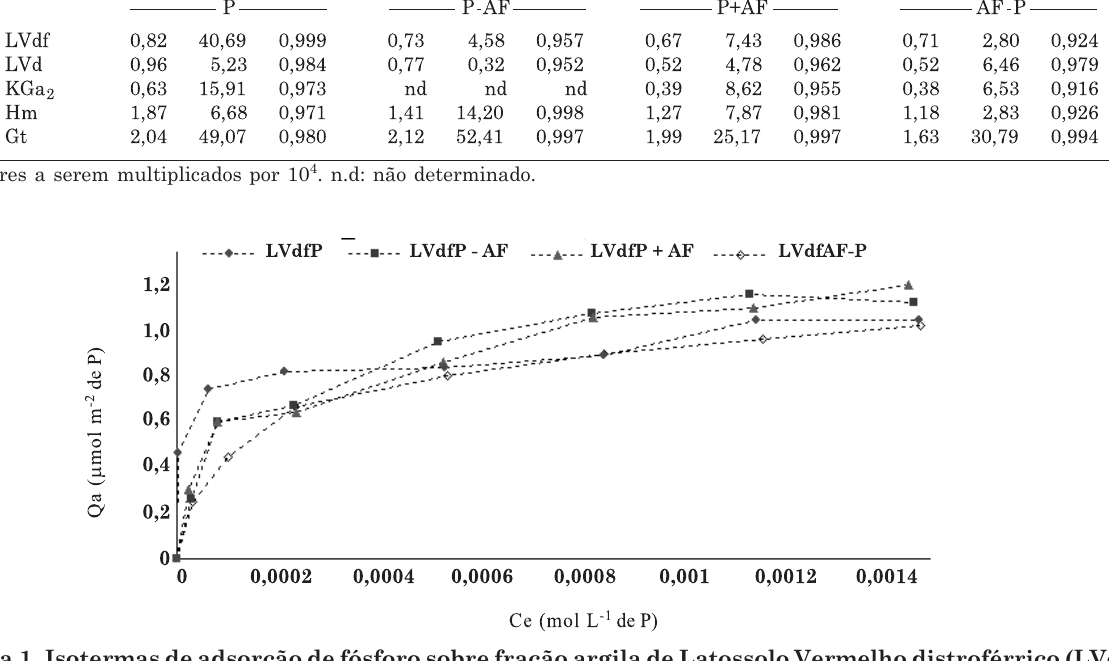
Figura 1. Isotermas de adsorção de fósforo sobre fração argila de Latossolo Vermelho distroférrico (LVdf) na presença de ácido